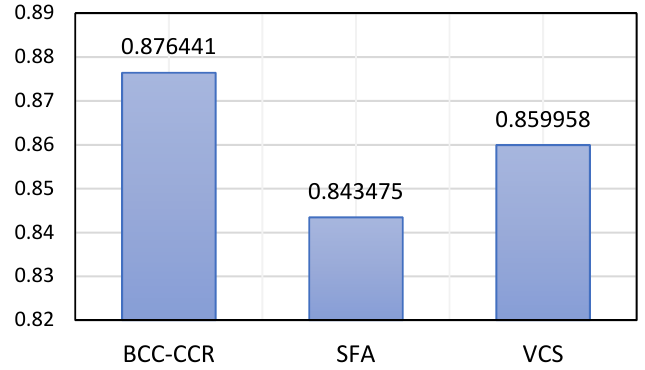
Figure 5. Evaluation of ATE for BCC-CCR, SFA, and VCS.